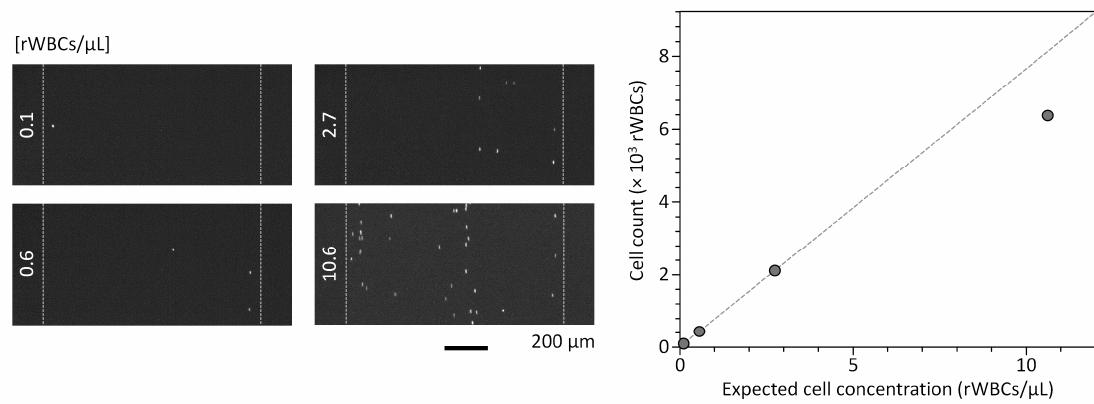
Figure 7. Handheld rWBC counting using the integrated microflow cytometer. Microscopic movies taken using the miniaturized fluorescence microscope were analyzed using the custom cell counting program. Each fluorescence image taken at a specific time point shows the difference in rWBC counts according to the cell concentration. The cell counting results obtained using the microflow cytometer exhibited a linear correlation with the injected rWBC concentrations, which ranged from 0.1 to 2.7 rWBCs/µL. The dotted line represents a linear regression line for the data points. Error bars represent standard deviation ( n = 3).